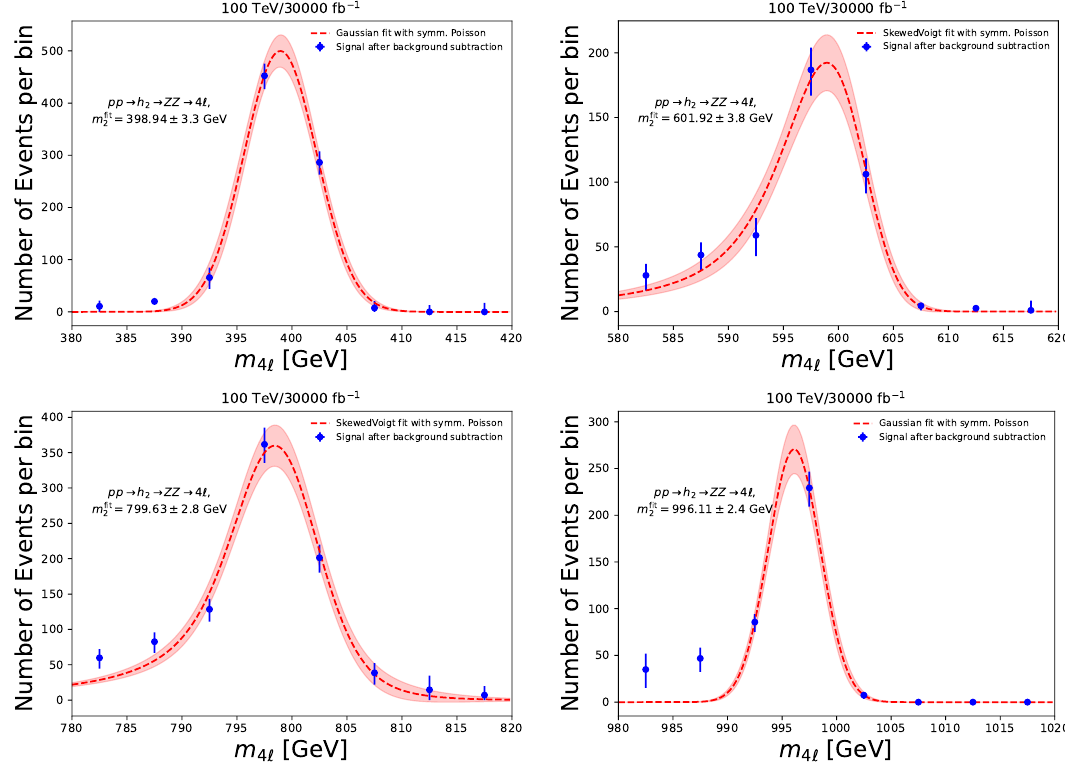
Figure 1 . A selection of results obtained through the mass fitting procedure outlined in the main text is shown. We show the fits for cross sections corresponding to significances of Σ ’ 10 in the pp → h 2 → ZZ → 4 ‘ channel at a 100 TeV collider with an integrated luminosity of 30 ab − 1 , for real masses m = 400 , 600 , 800 , 1000 GeV corresponding to top left, top right, lower left and lower 2 right. The blue error bars represent the expected number of signal events in each bin and the red dashed curve and red error band represent the fit and its corresponding uncertainty as obtained by the lmfit